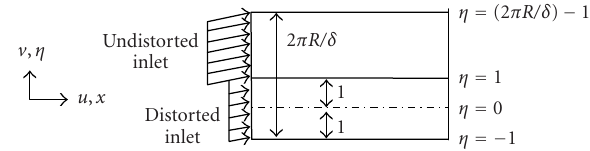
Figure 2: A schematic of coordinates transformation on computational